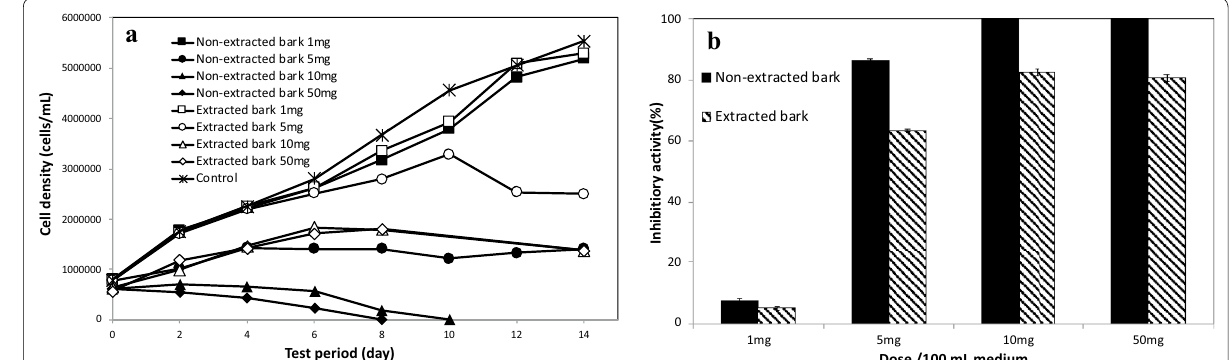
Fig. 1 Growth curve of M. aeruginosa during the 14‑day bioassay ( a ). The inhibitory activity of bark powder compared with control after the bioassay ( b ). Bar: standard error